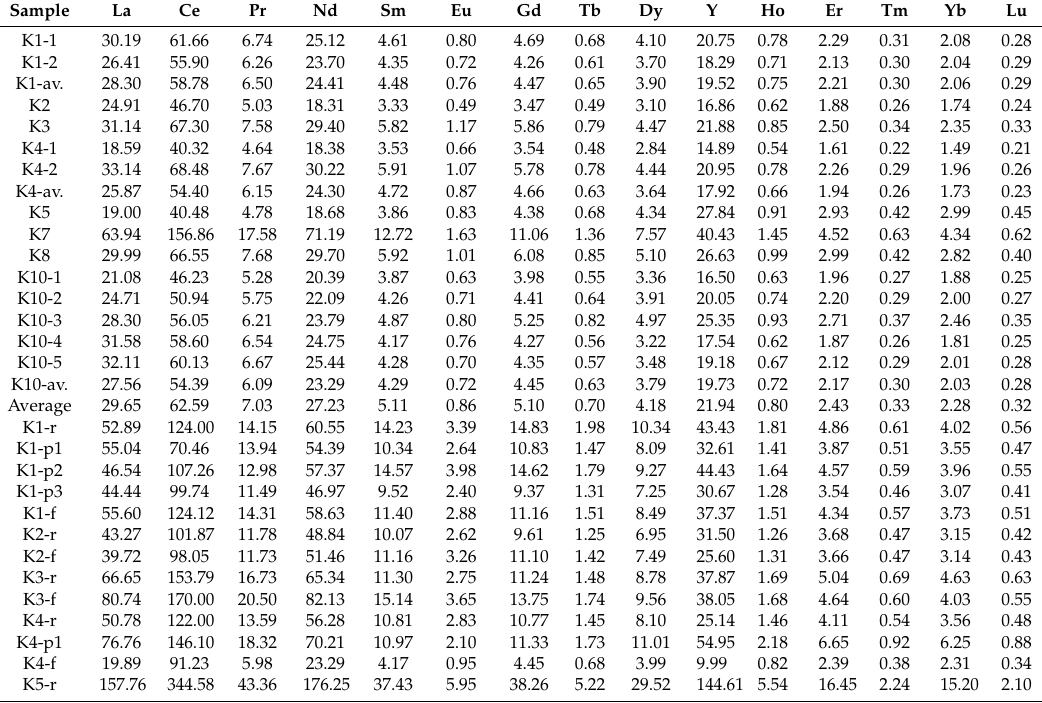
Table 4. Concentrations of rare earth element and yttrium (REY) in the coal and non-coal samples from the ZK4-1 drill core in the Zhongliangshan Coalfield ( µ g/g). Sample